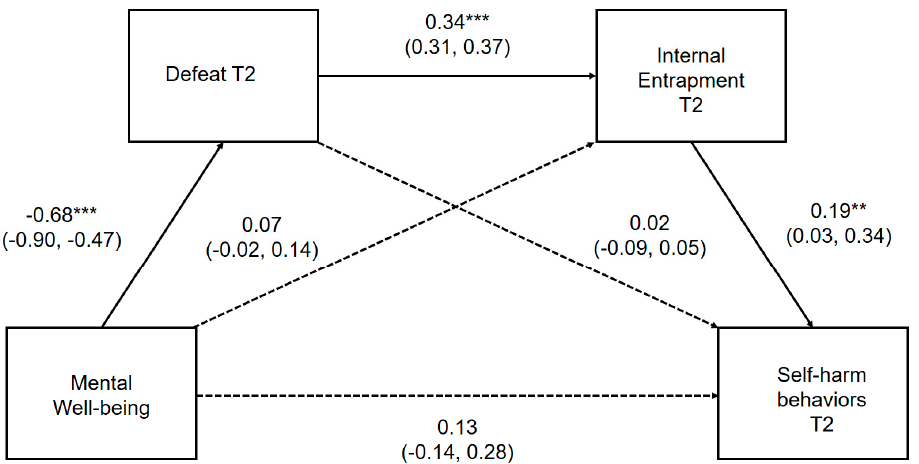
Figure 4. Serial multiple mediation model for the association between mental well ‐ being and prospective self ‐ harm behaviors, via defeat and internal entrapment. ** p < 0.01, *** p < 0.001 Serial multiple mediation model with unstandardized regression coefficients and 95% bias corrected confidence intervals. Significant pathways highlighted in bold.